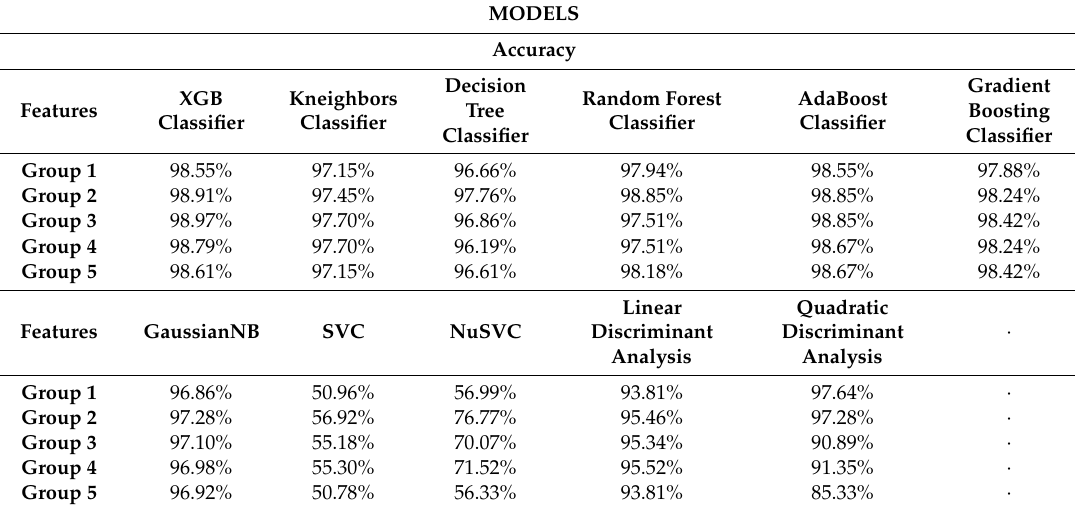
Table 5. The accuracy obtained by the models implemented for each group of features.